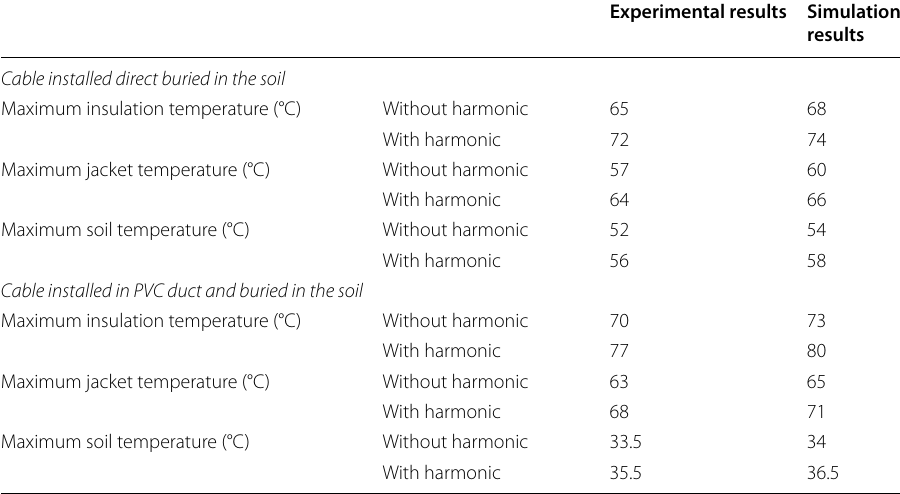
Table 3 Summary of the obtained temperature from experimental and simulation results of tested